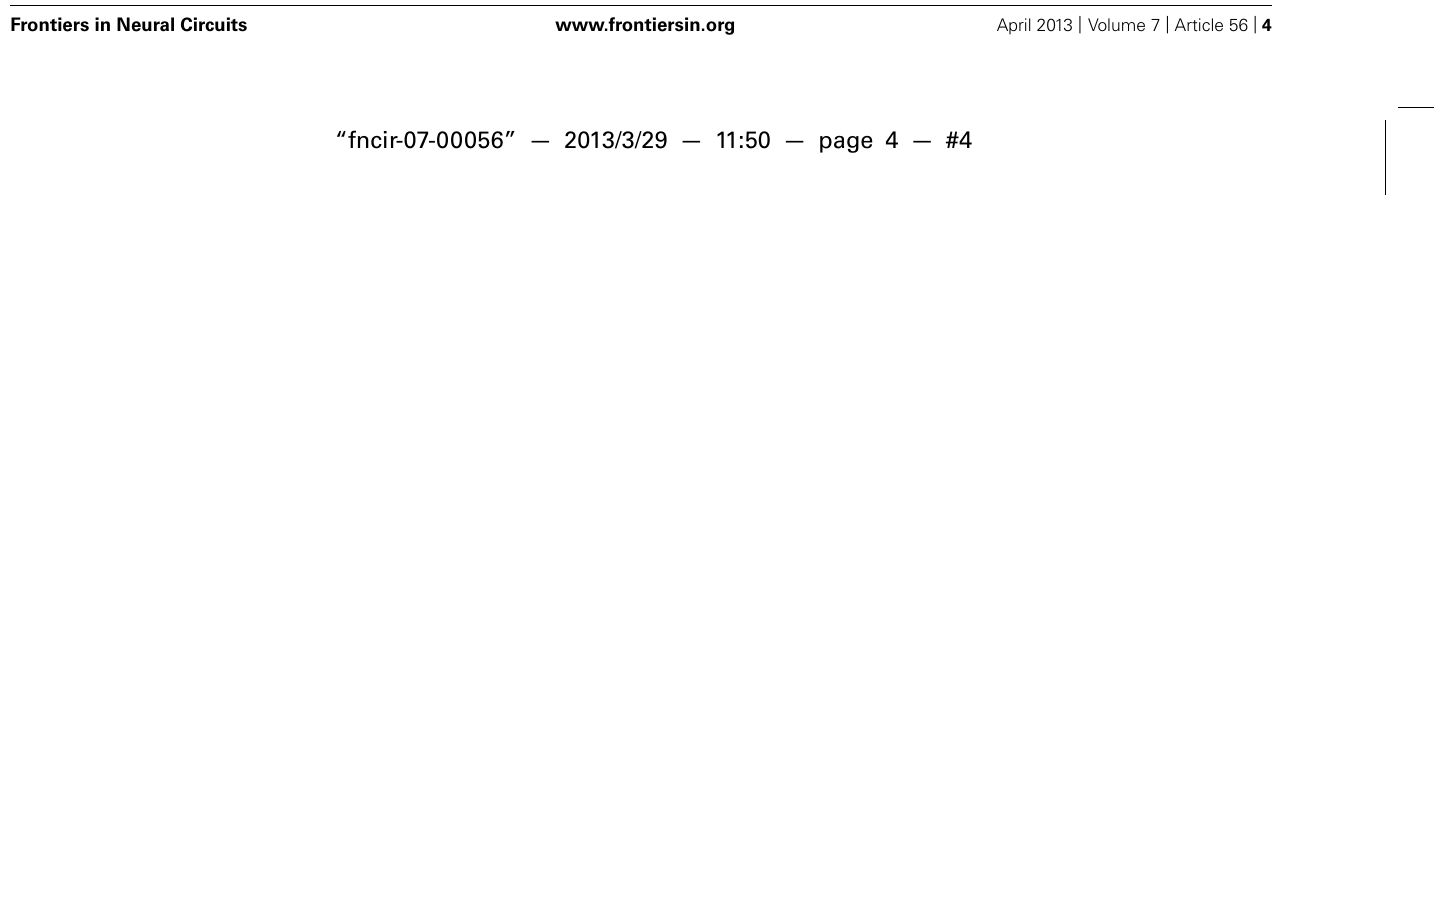
FIGURE 1 | mDCN neurons project to the contralateral reticular formation, as revealed by anterograde tracing. (A) Tracer injection site in the mDCN (Med), approximately − 6.3 from bregma. (B) Low power image of labeling in the rostral brainstem in both the ipsilateral and contralateral Gi and LPGi, approximately − 6.0 from bregma. At higher power, punctate labeling indicates terminal fields in contralateral Gi (C) ; relatively fewer terminals are found on the ipsilateral side (D) .The level for (E,F) is